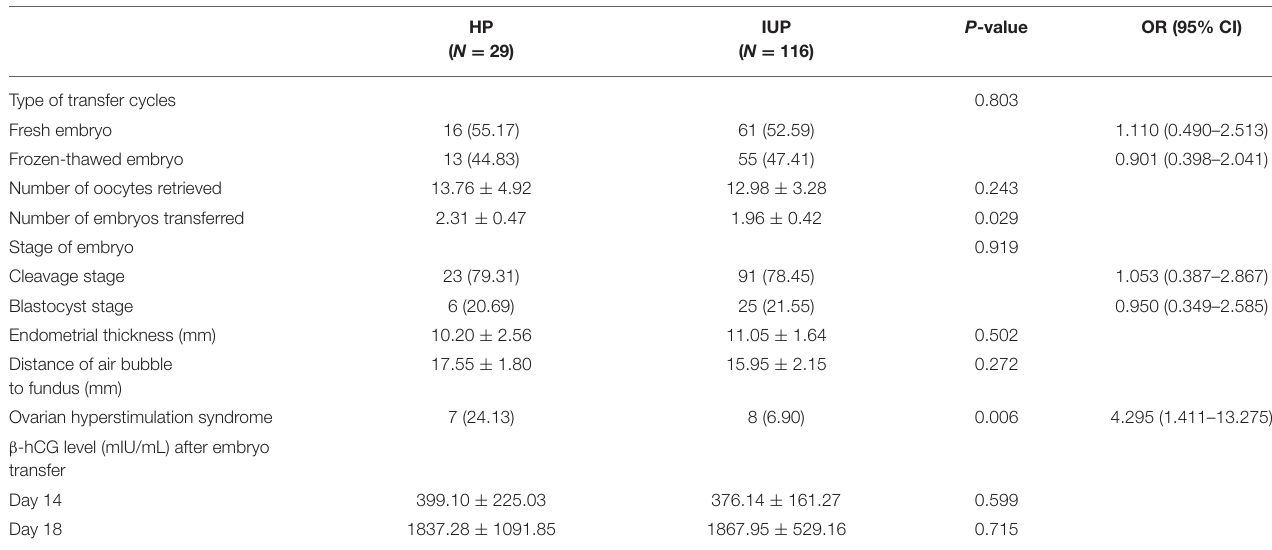
TABLE 2 | ART procedure characteristics of study